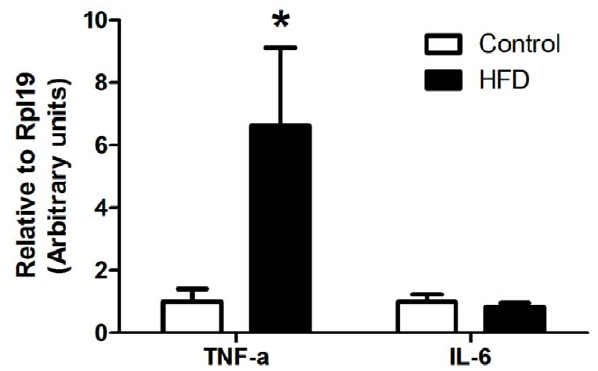
Figure 3. Effect of high saturated fat diet (HFD) on markers of inflammation in proximal colon. mRNA expression of indicated genes was measured by RT-qPCR as described in Figure 2. Open bars=control; Closed bars=HFD (n=11–16 per group). Data are shown as mean 6 SEM. * P , 0.05 compared to